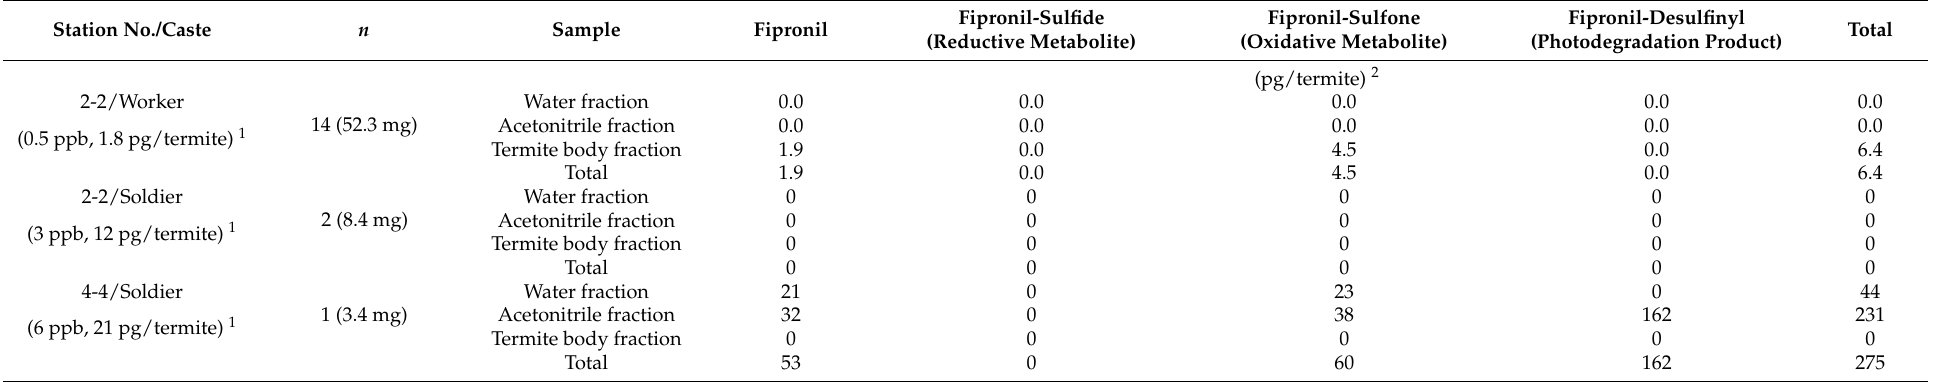
Table 4. Fipronil and its sulfide, sulfone, and desulfinyl derivatives detected in worker and soldier caste termites of Coptotermes formosanus collected in Isogi Park one week after the soil treatment.